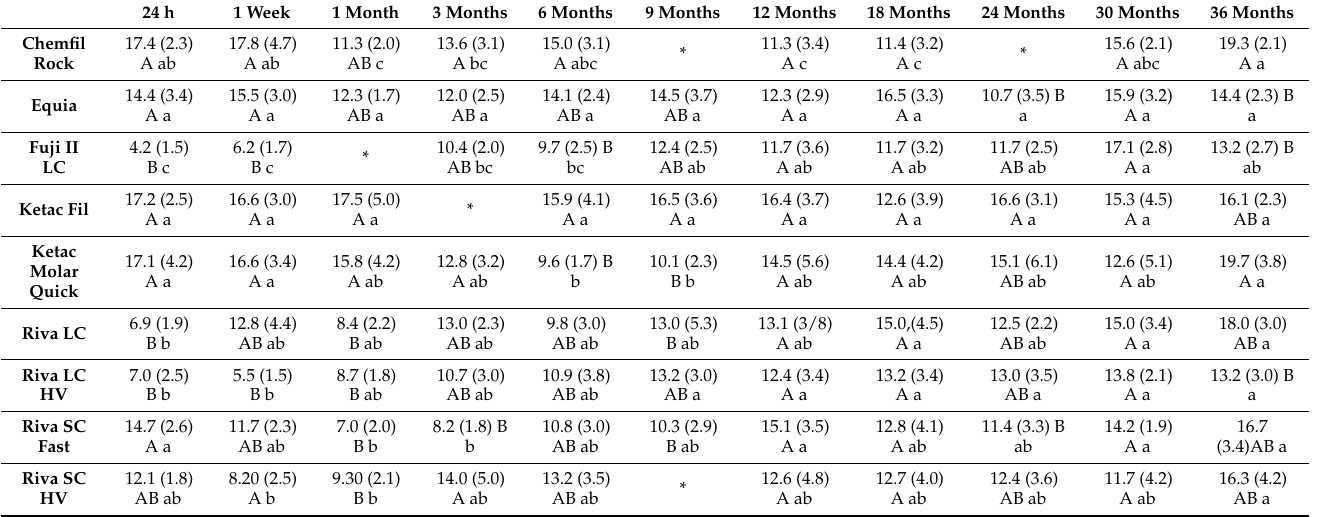
Table 3. Mean Unbound Water Enthalpy